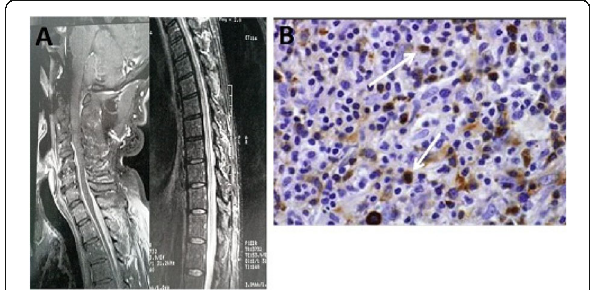
Fig. 1 (abstract P229). A: T1-weighted magnetic resonance (MR) imaging, showing hyperintense linear dural thickening in cervical